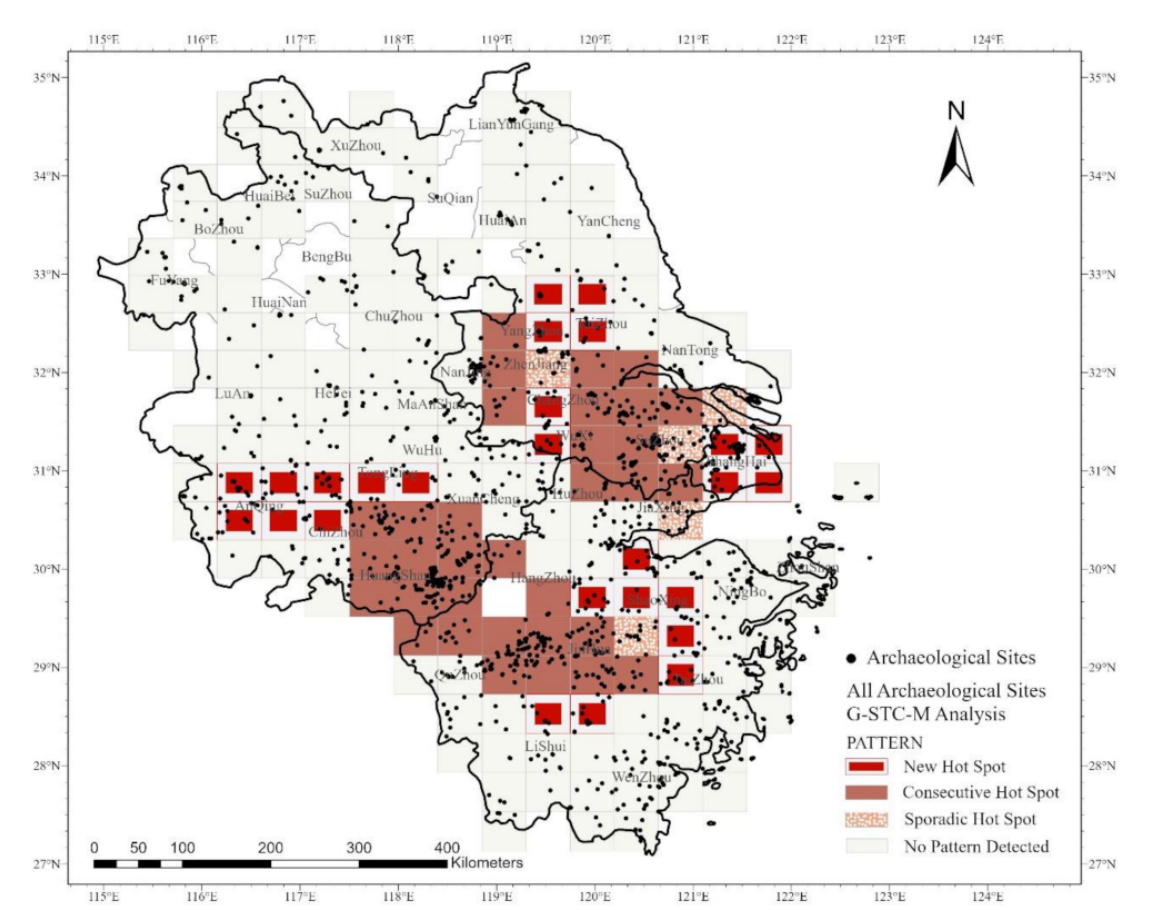
Figure 11. G-STC-M analysis of Archaeological